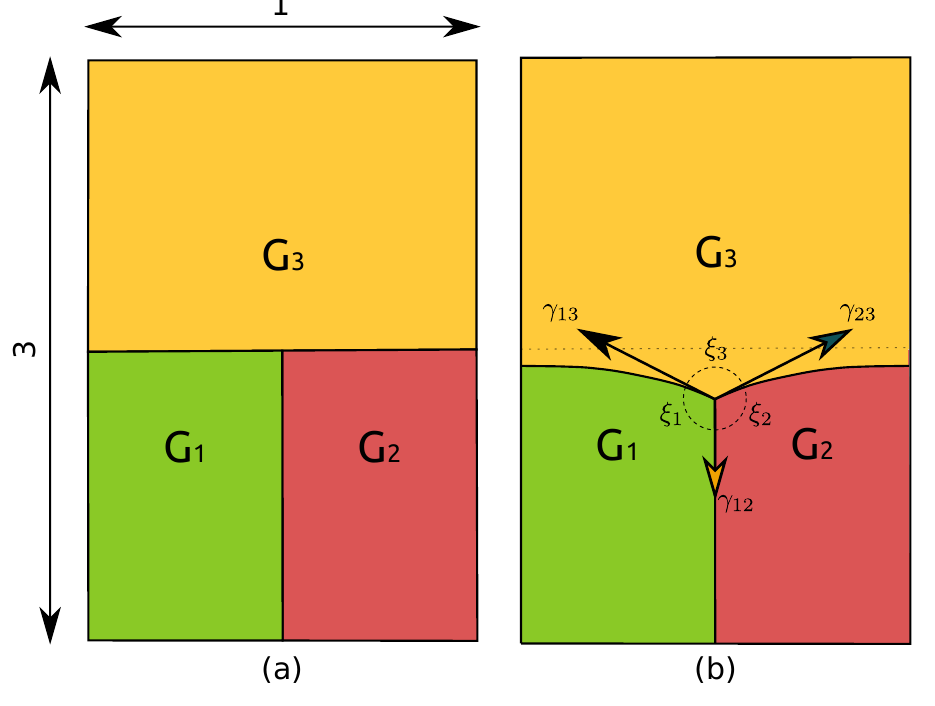
Figure 2. T-shape triple junction ( a ) and an illustration of the triple junction migration showing the dihedral angles and GB energies ( b